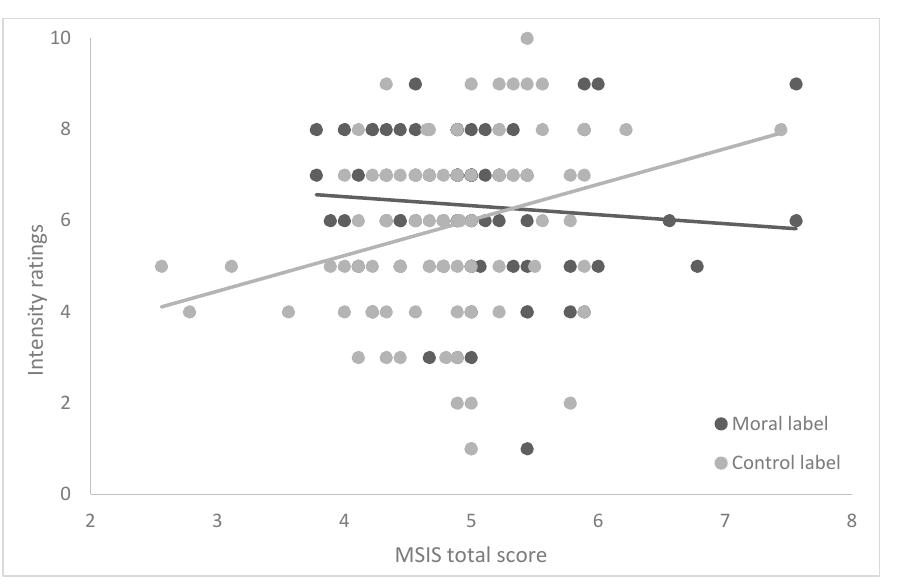
Figure 2. The interaction between moral self-image and label type on ratings of the beer’s expected intensity.